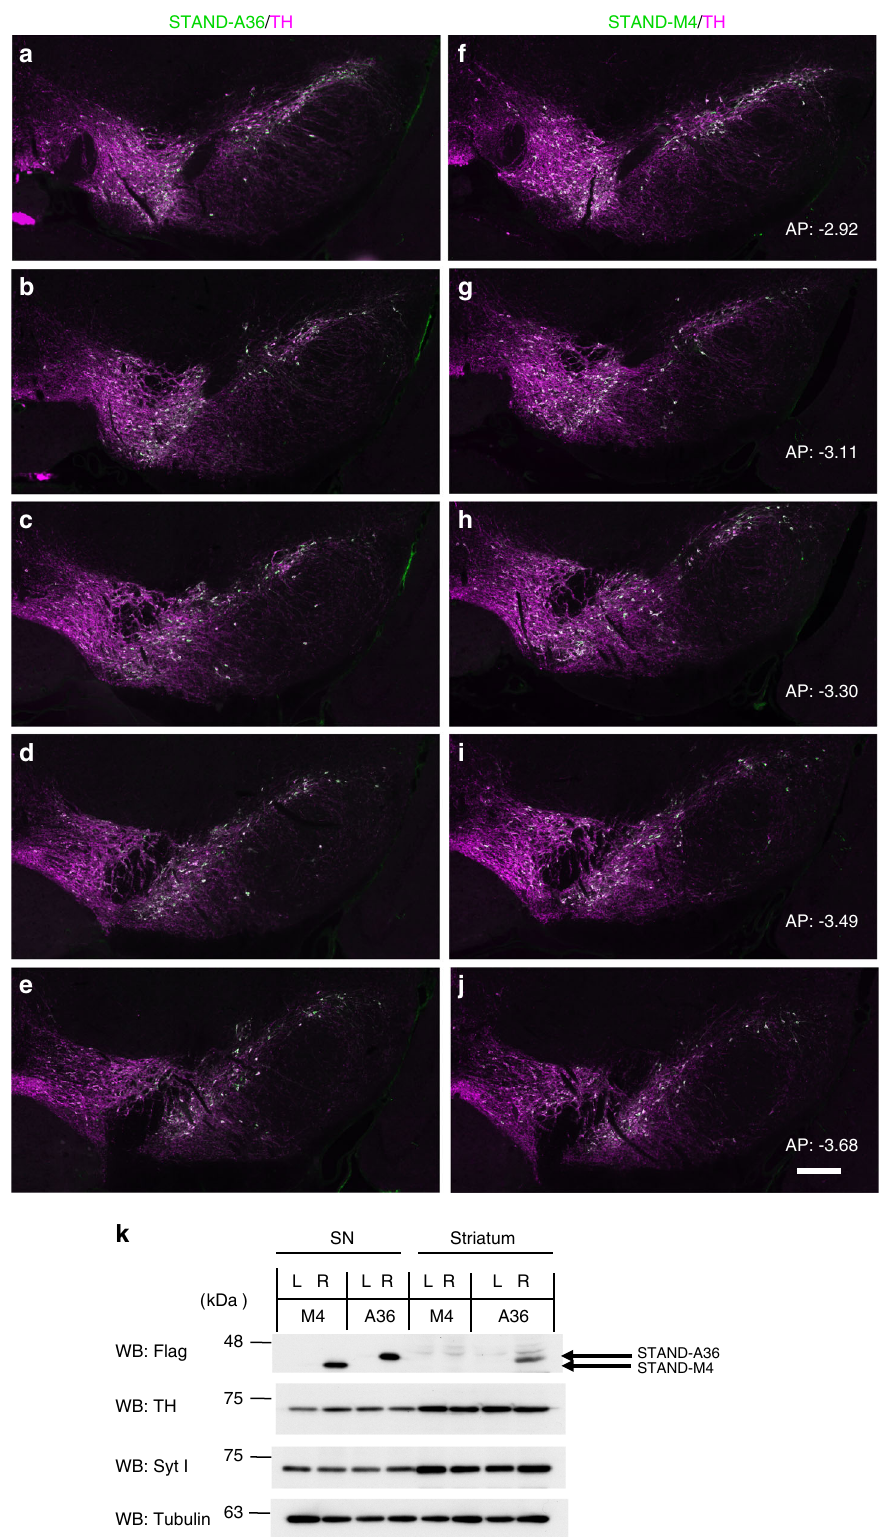
Fig. 5 Stable expression of STAND proteins in a broad region of the SNc. Brain sections (AP coordinates relative to bregma in mm: − 2.92, − 3.11, − 3.3, − 3.49, and − 3.68) 33 days after injection with AAV9/3-STAND-A36 ( a – e ) or AAV9/3-STAND-M4 ( f – j ). STAND proteins (green) were expressed in tyrosine-hydroxylase (TH)-positive (magenta) dopaminergic neurons (white, in merged images). k Immunoblot analysis of total homogenates of the striatum and SNc from the left (L) and right (R) hemispheres of the mouse brain 33 days after injection with AAV-vectors; anti-Flag (STAND proteins), anti-TH, anti-Syt I, and anti-tubulin antibodies. Scale bar, 200 μ